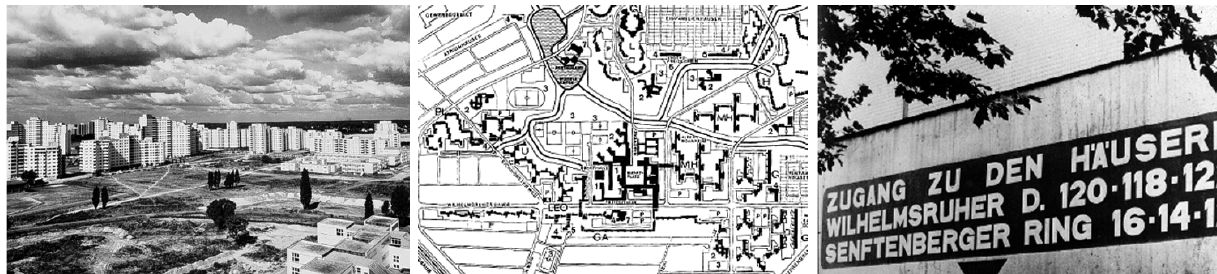
Figure 6. The post-war car-oriented city in Berlin: Märkisches Viertel. Source: Wilde (1989). Urban Planning, 2019, Volume 4, Issue 3, Pages